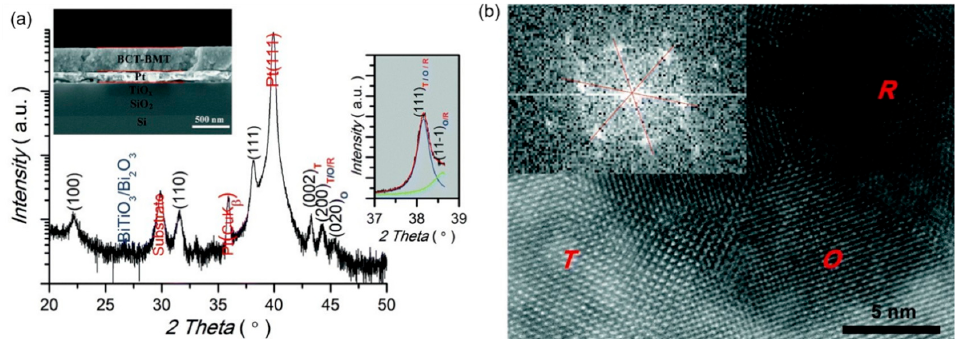
Figure 26. 0.5(Ba 0.8 Ca 0.2 )TiO 3 -0.5Bi(Mg 0.5 Ti 0.5 )O 3 (BCT–BMT) thin film. ( a ) XRD pattern diffraction intensity is in a logarithmic scale. A tiny amount (less than 1%) of secondary phases (BiTiO 3 or Bi 2 O 3 ) can be detected. Inset: Cross-sectional SEM image. ( b ) Atom-scale HRTEM image. Inset: The fast Fourier transform spectrum of the R region. Reprinted with permission from [92]. Copyright 2019 The Royal Society of